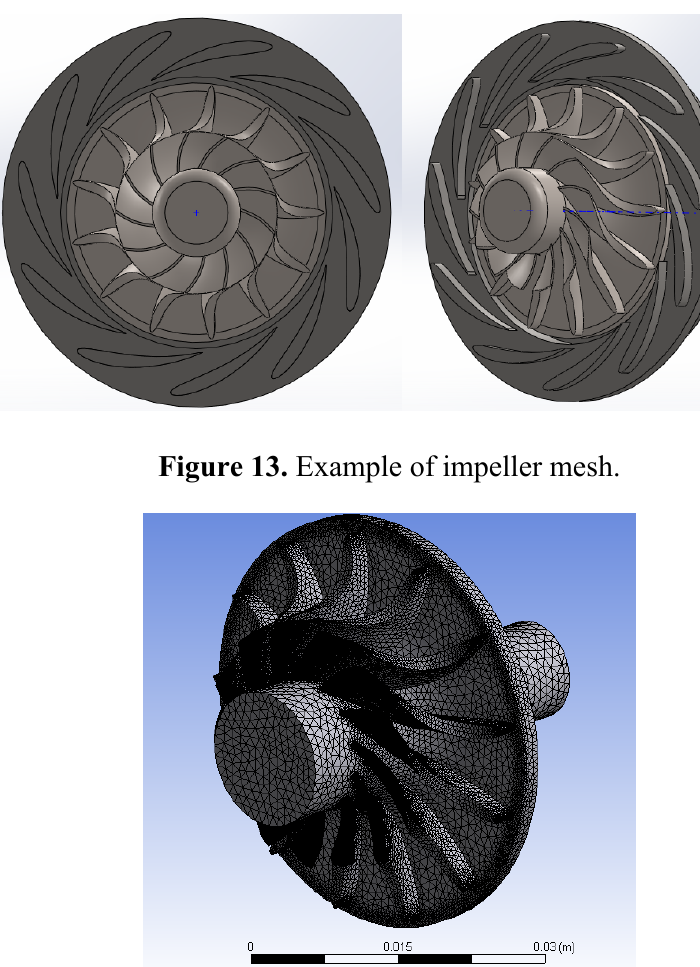
Figure 12. 3D sketch for the expander stator and impeller.